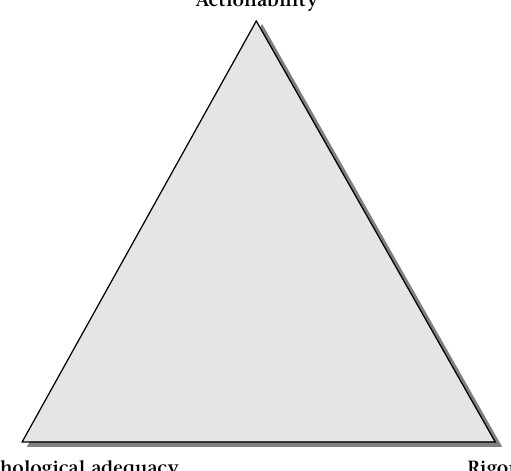
Figure 1: The dimensions of validity as an action